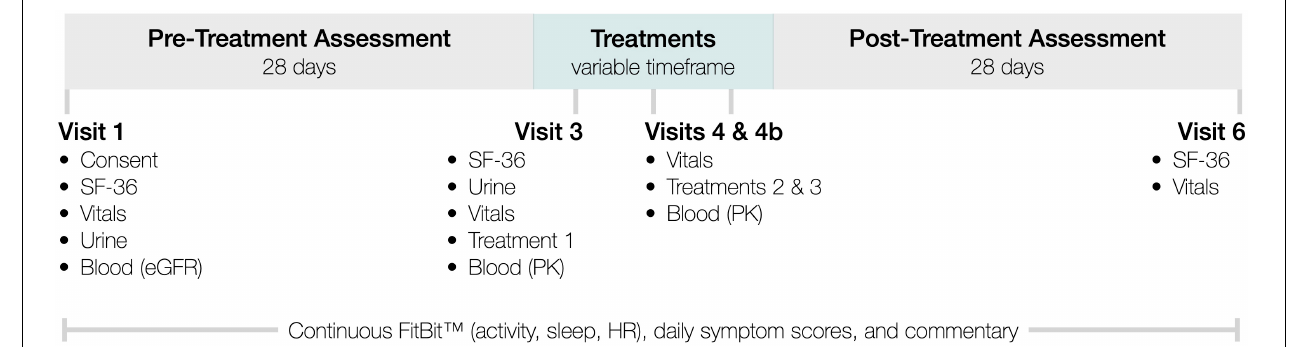
FIGURE 2 | InTiME